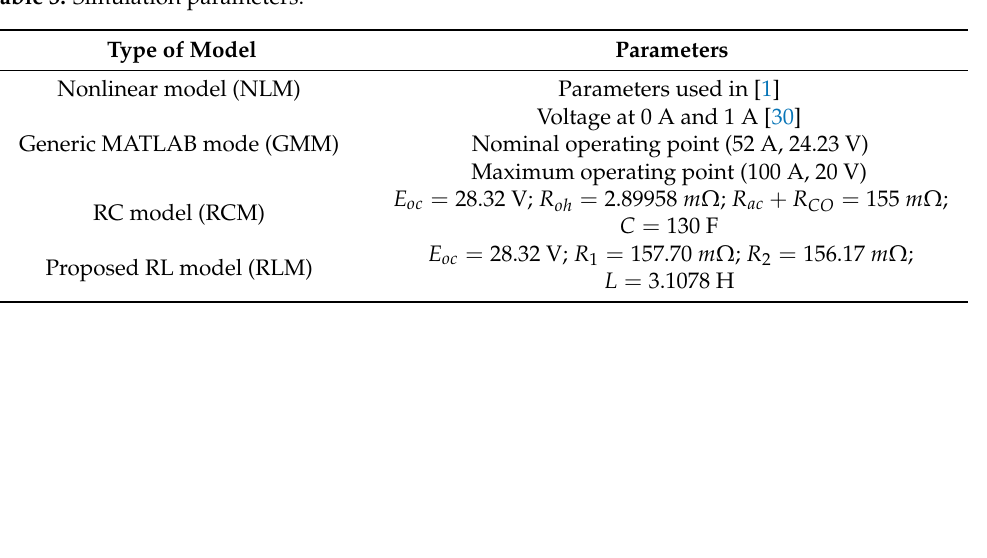
Figure 11. Simulated models in MATLAB/Simulink: ( a ) nonlinear model (NLM); ( b ) generic MATLAB model (GMM); ( c ) RC model (RCM); and ( d ) RL model (RLM). Table 3. Simulation parameters.